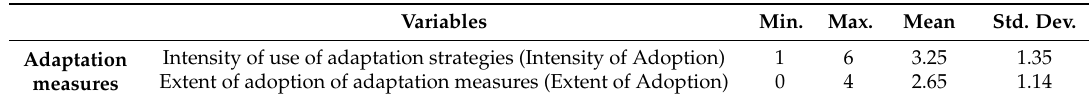
Table 2. Description of dependent variables.